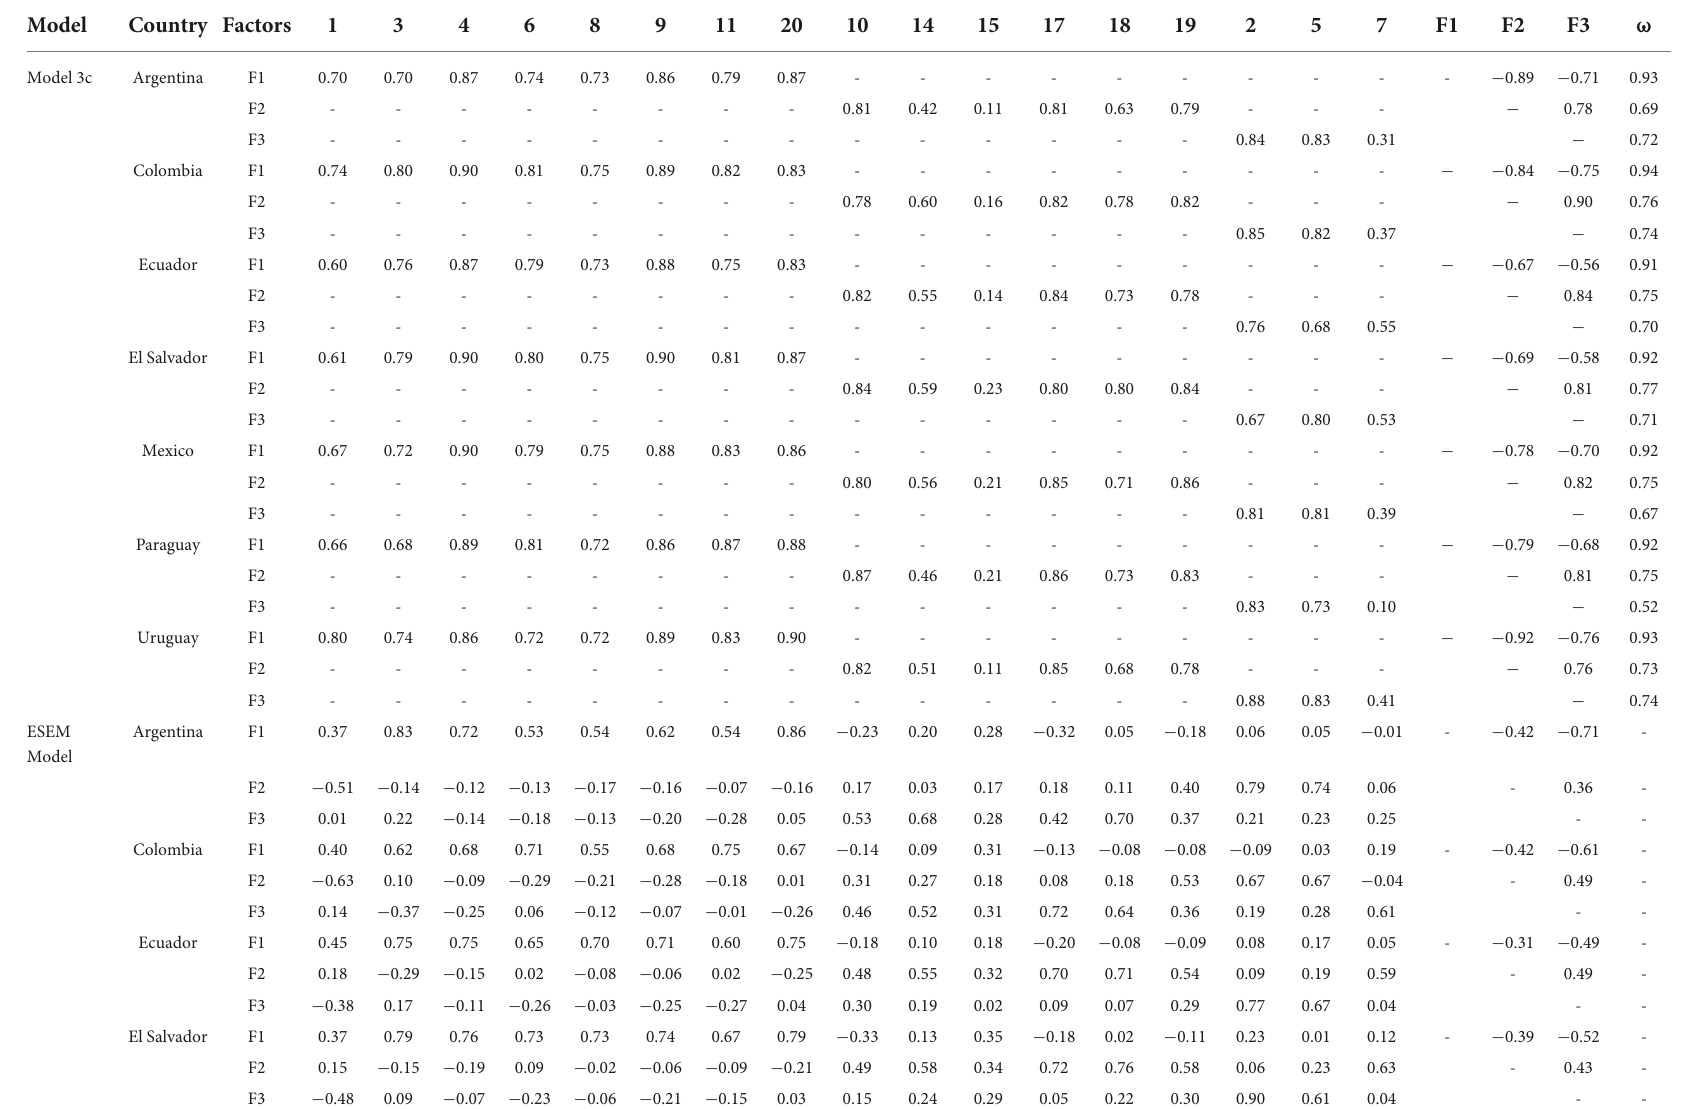
TABLE 3 Factorial weight and reliability of the PIL scale by